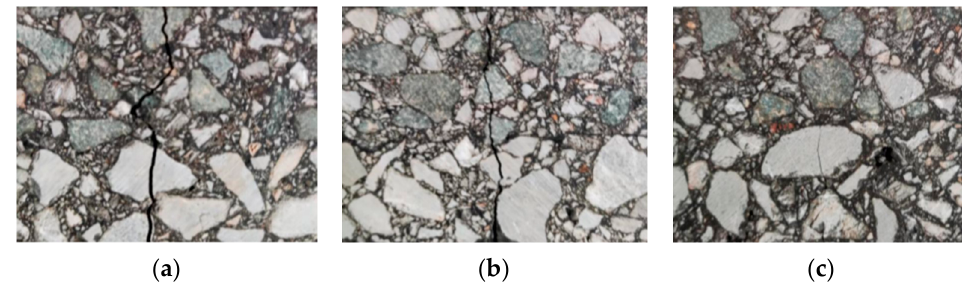
Figure 5. The cracking energy of the six types of asphalt samples.